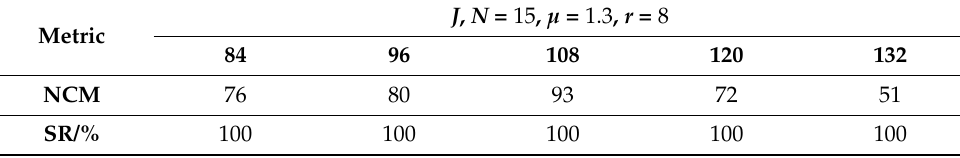
Table 5. The results of parameter J